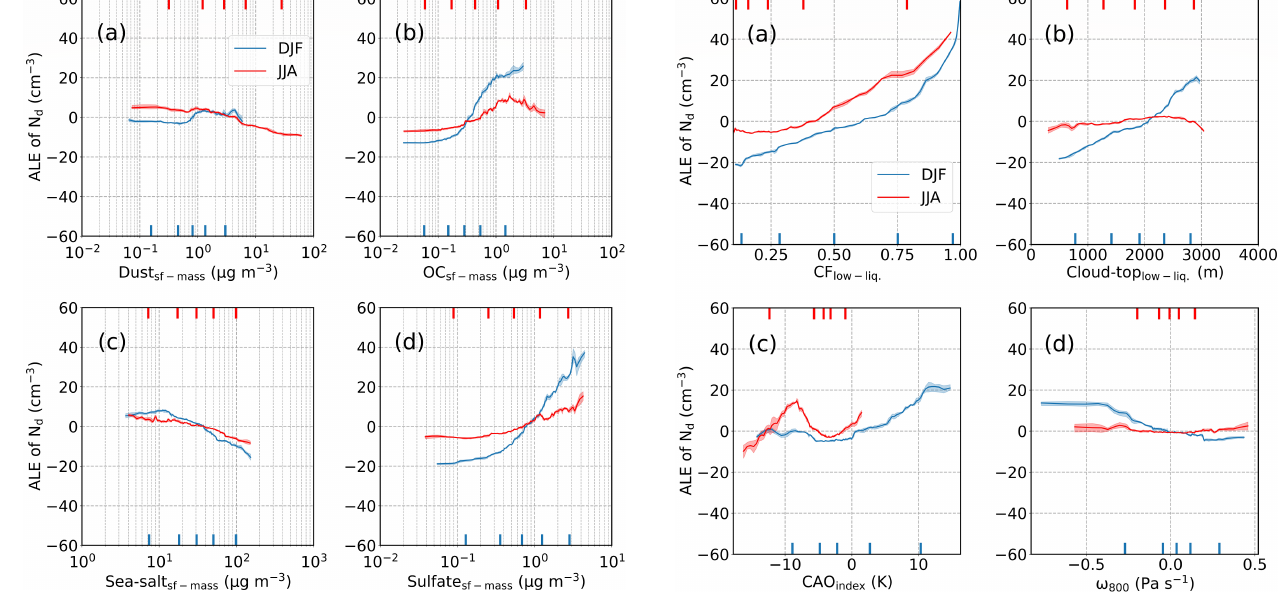
Figure 15. Same as Fig. 14 but for the following input parameters: (a) low-level liquid cloud fraction (CF low-liq. ), (b) cloud-top effec- tive height of low-level liquid cloud (cloud-top low-liq. ), (c) cold-air outbreak (CAO) index, and (d) vertical pressure velocity at 800hPa ( ω 800